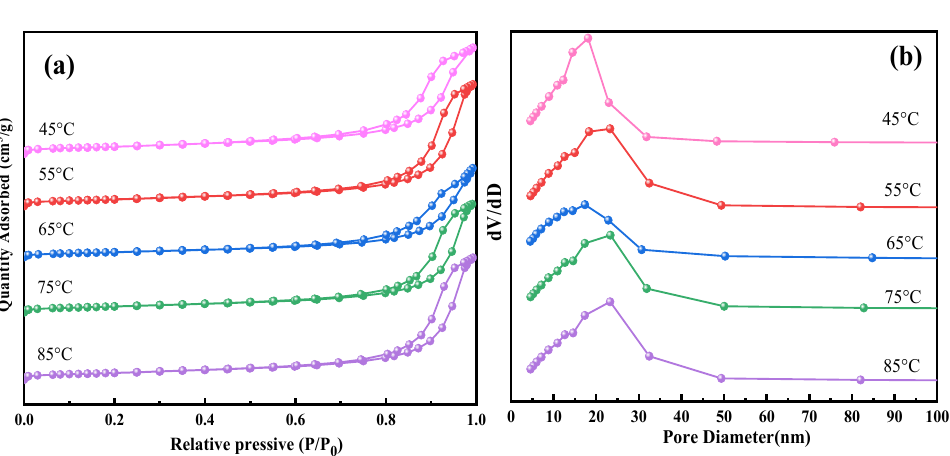
Figure 1. ( a ) N 2 adsorption/desorption isotherms and ( b ) pore size distribution curves of Table 1. BET surface area, BJH mean pore size, pore volume, and elemental composition of cata- lysts.